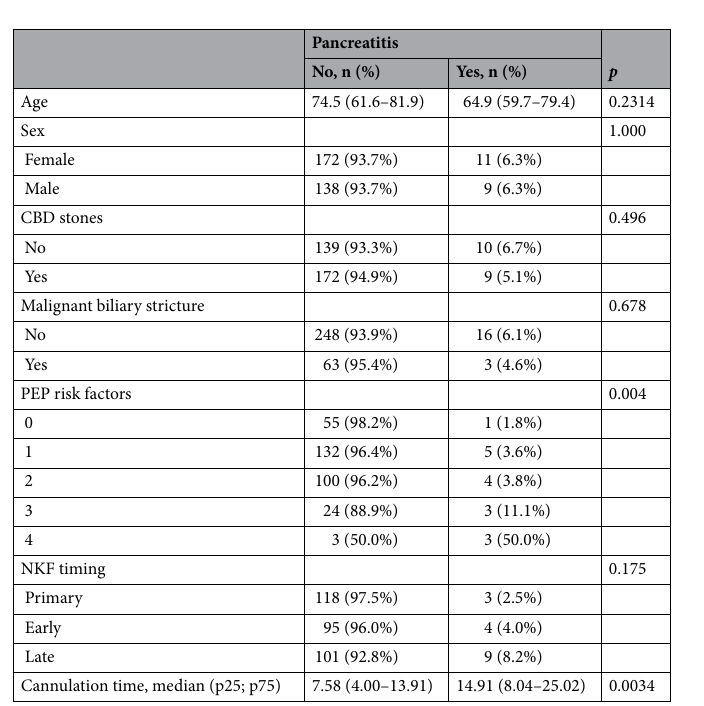
Table 3. Univariate analysis for evaluating possible associations for pancreatitis. p25–p75: lower and upper limit of the interquartile